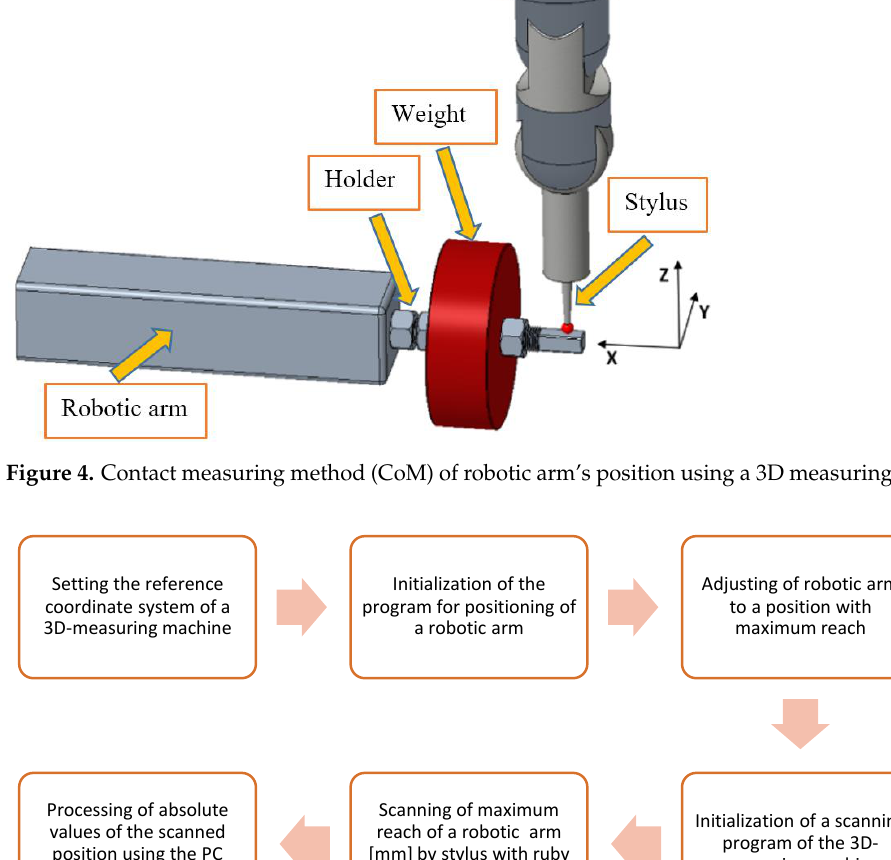
Figure 4. Contact measuring method (CoM) of ro botic arm’s position using a 3D measuring ma- chine.